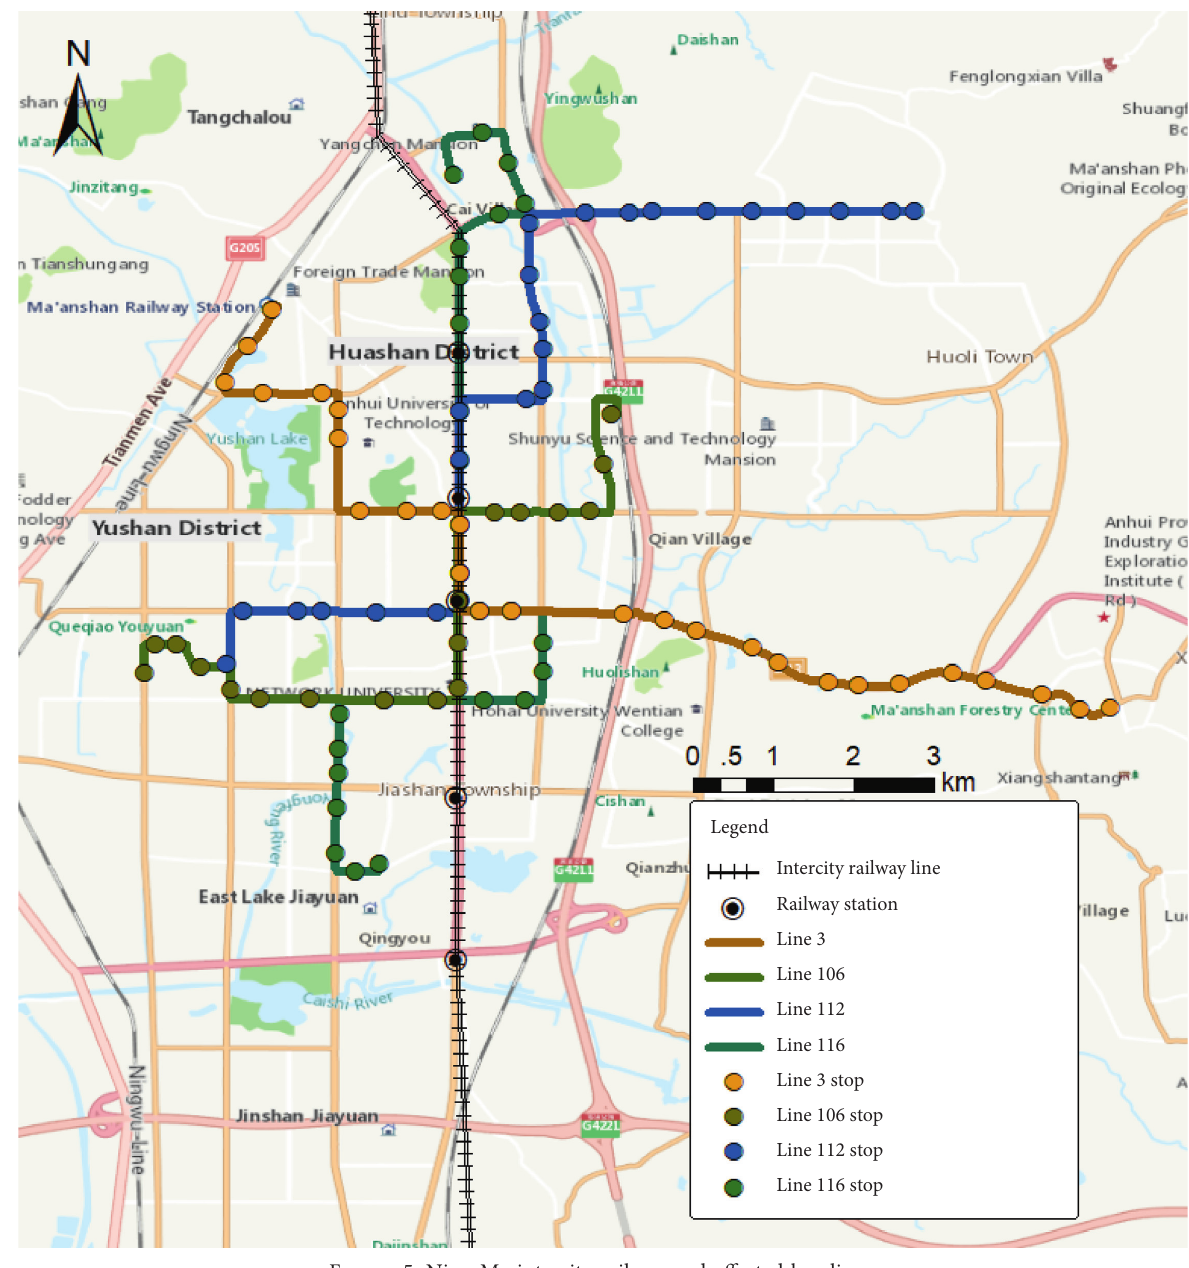
Figure 5: Ning-Ma intercity railway and affected bus